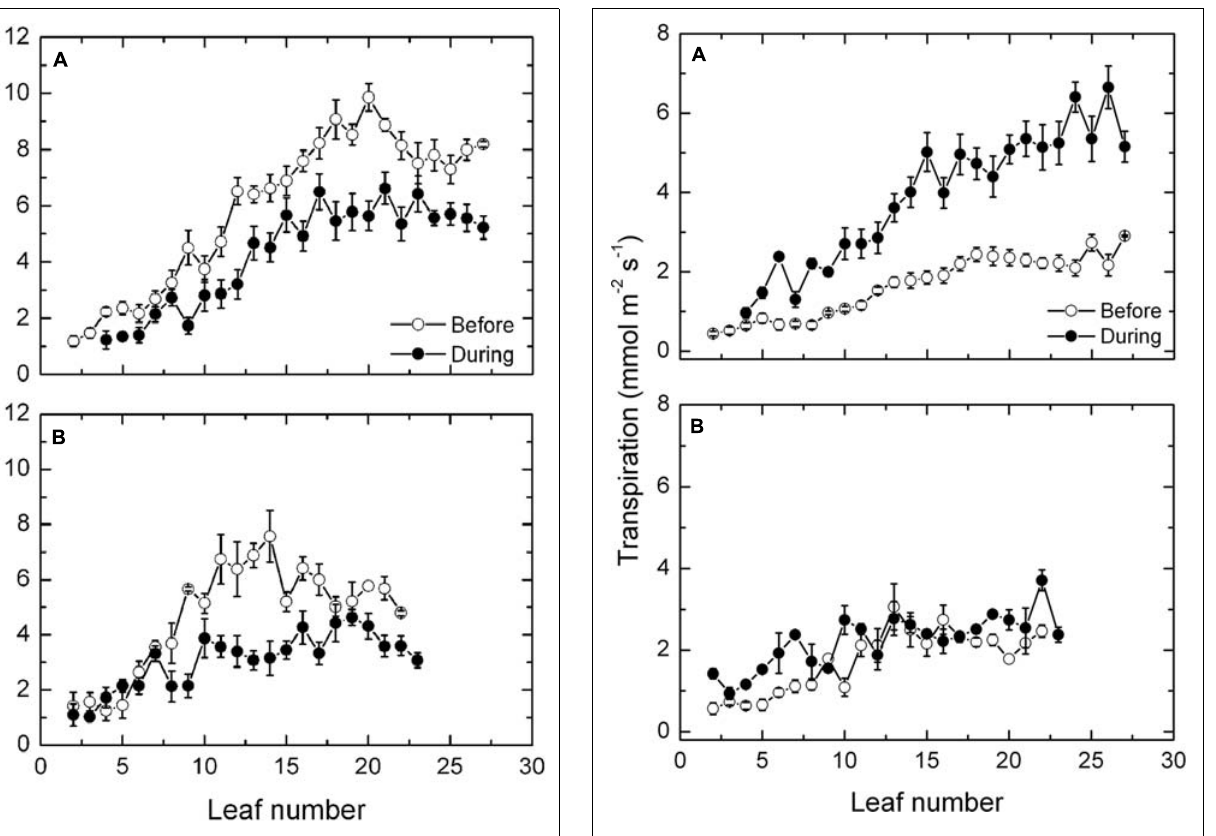
FIGURE 3 | (A,B) Net photosynthesis (mean ± SE, N = 12) at different leaf positions along the shoot of Semillon vines either prior to (7th January, 104 DAB) or on one day (4th February, 132 DAB) during the 14-day period of high temperatures as indicated.The vines were grown in an irrigated vineyard (A) without protection and (B) with protection provided by shade cover over the vines.